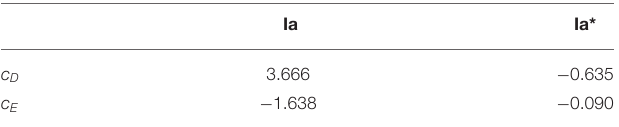
TABLE 1 | c D and c E values of the contact terms in the three-nucleon interactions obtained from fits to (i) the nd scattering length and the trinucleon binding energies [27, 47]; and (ii) the central value of the 3 H GT matrix element and the trinucleon binding energies (starred values).